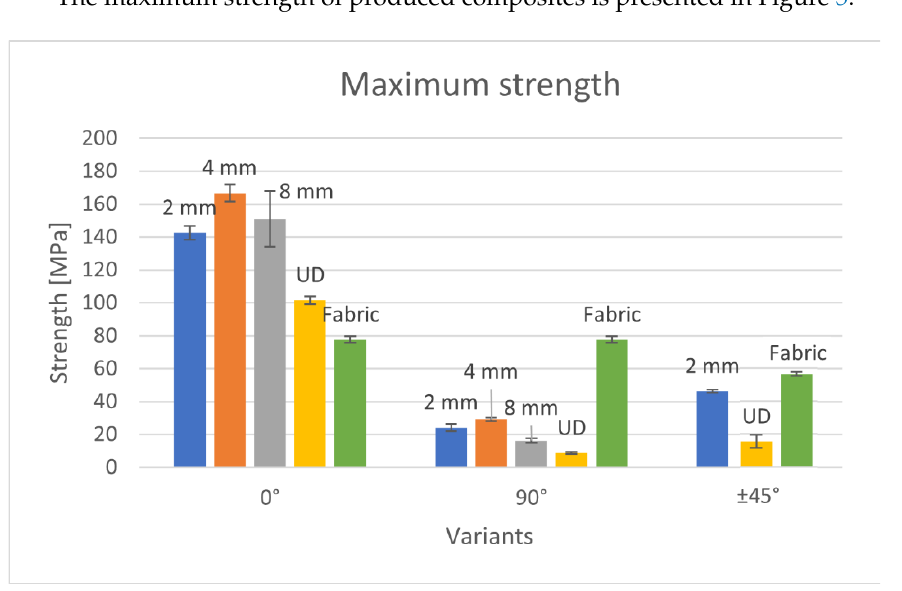
Figure 5. Strength of the produced composites.